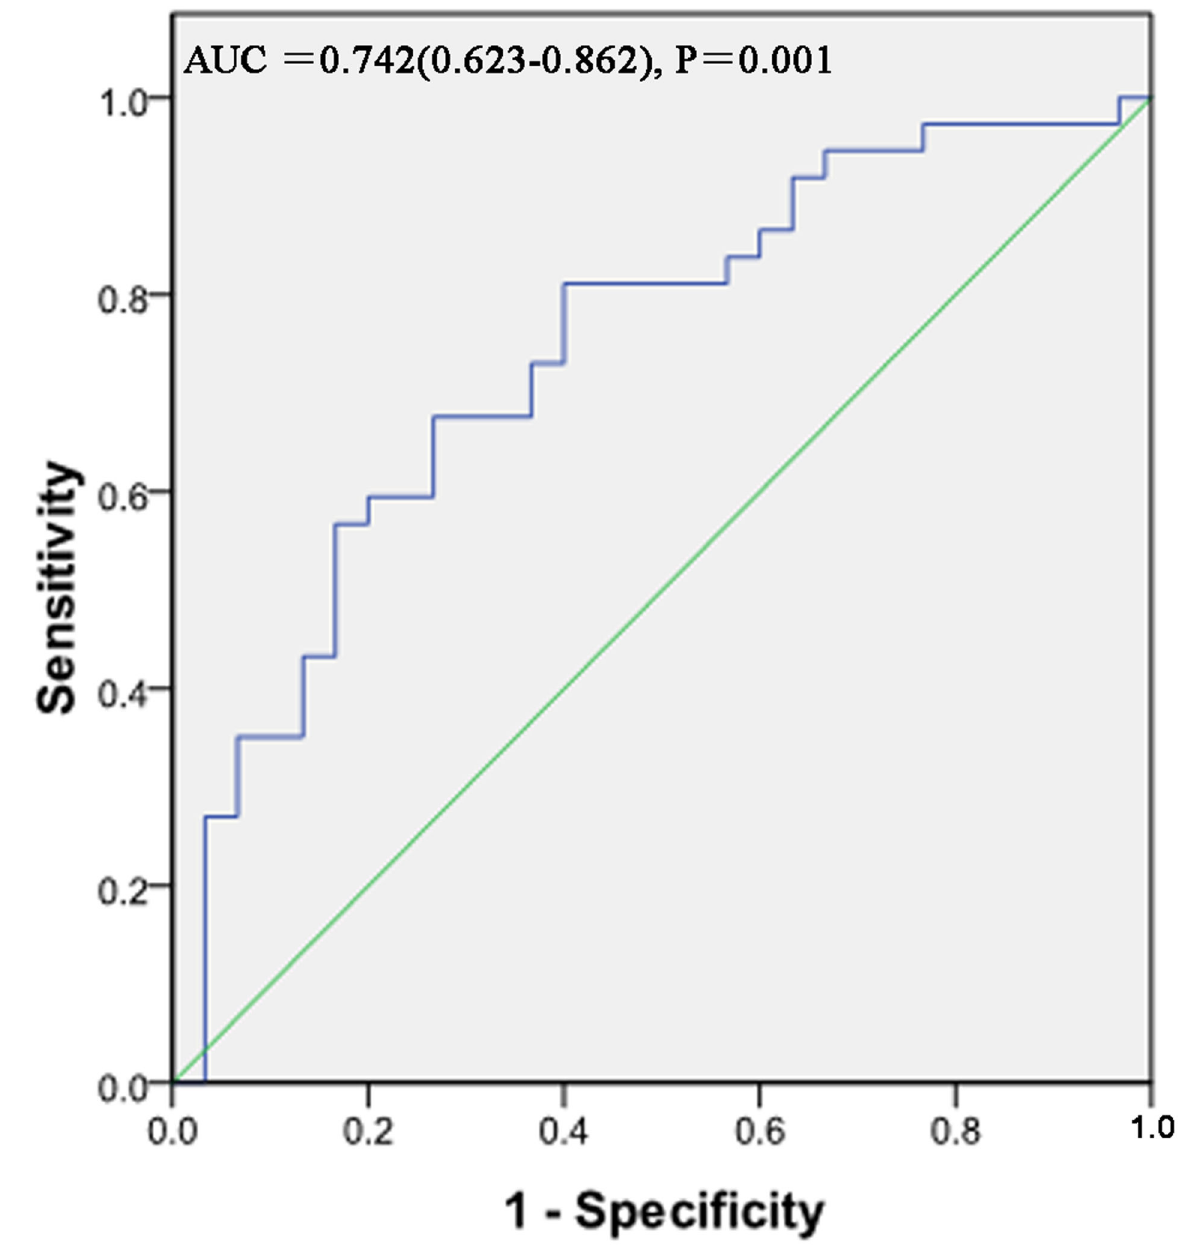
Figure 3. Receiver-operating characteristic (ROC) curve for anthropometric assessment FM in assessing nutrition status using MIS as the reference standard. ( *P < 0.05)